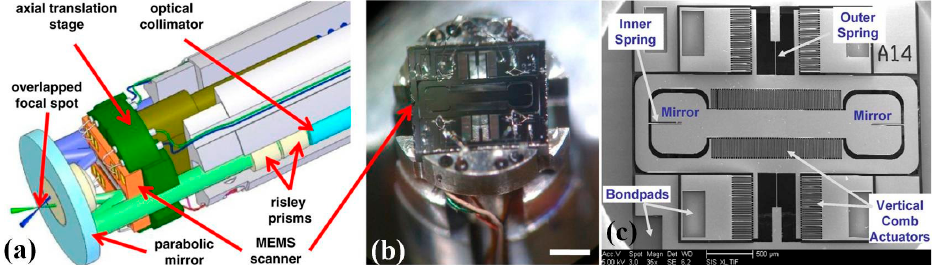
Figure 10. Outer diameter 5.5 mm diameter dual-axis confocal (DAC) endomicroscope scanhead. ( a ) Two collimated beams are focused by a parabolic mirror. Real-time en-face scanning is performed by a two-dimensional MEMS scanner. ( b ) Photograph of the endomicroscope without its cap showing a two-dimensional MEMS scanner mounted on the axial translation stage, scale bar is 3 mm. ( c ) SEM image of the two-dimensional electrostatic MEMS scanner (Reproduced with permission from SPIE [76]).